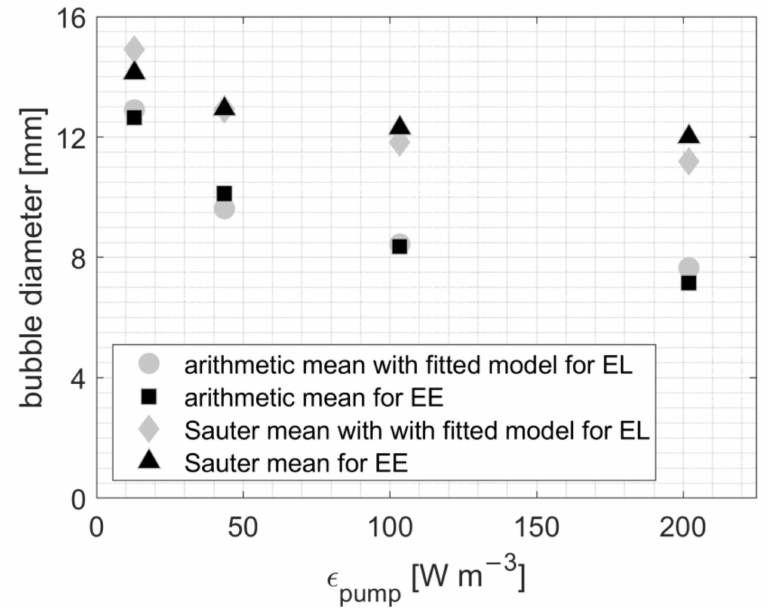
Figure 10. Arithmetic diameter and Sauter diameter of the bubble breakage model given by Lehr et al. The solution is compared with the EE approach and the fitted model in EL. Shown for pump volume flow 13, 44, 103 and 202 W m − 3